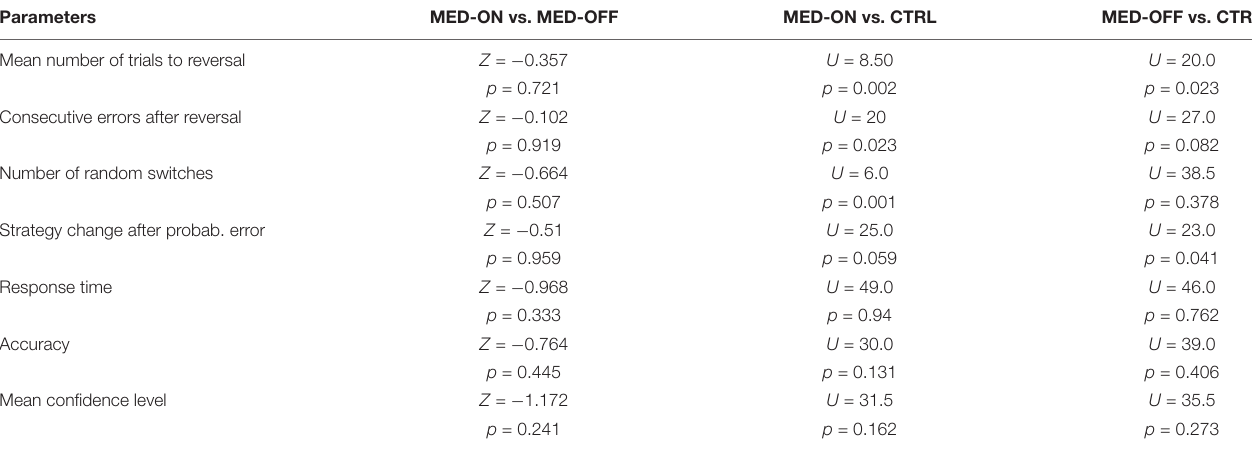
TABLE 3 | Summary of statistical results for the comparison between conditions MED-OFF, MED-ON, CTRL for RL and performance parameters. Parameters MED-ON vs. MED-OFF MED-ON vs. CTRL MED-OFF vs. CTRL Mean number of trials to reversal